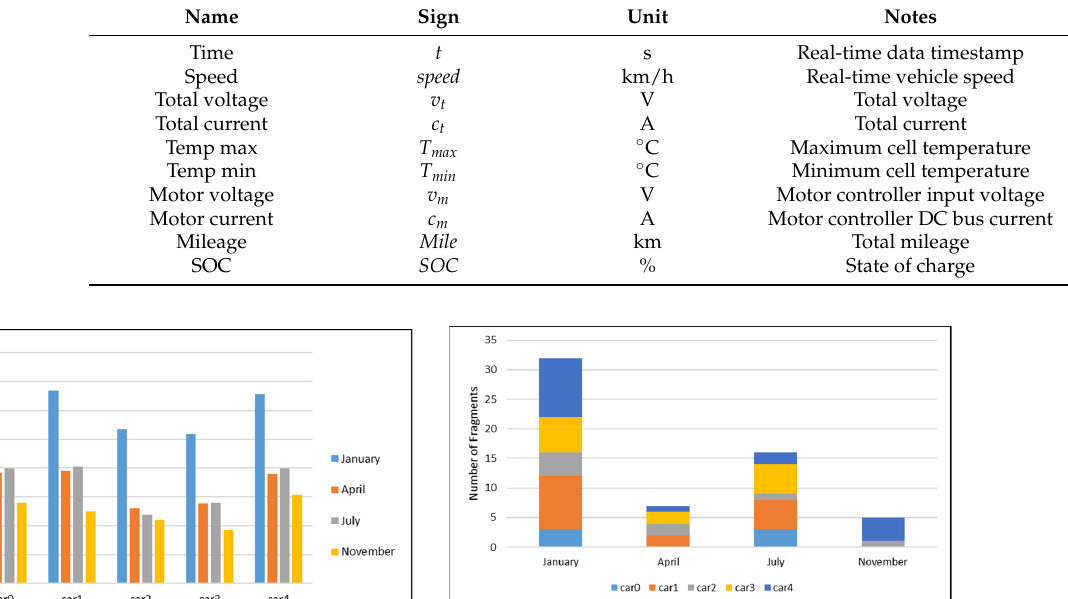
Table 1. Nine measured parameters from each set of data.